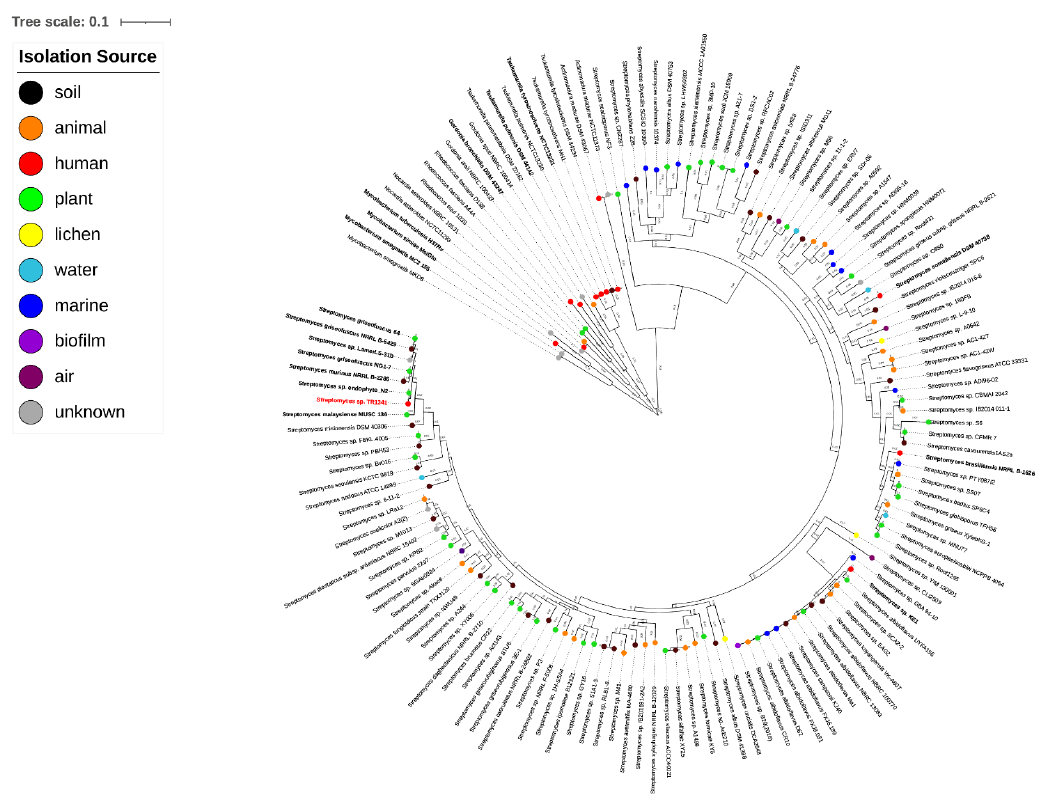
Figure 1. Phylogenetic tree based on orthologous families calculated with Orthofinder. Branch lengths are indicated.